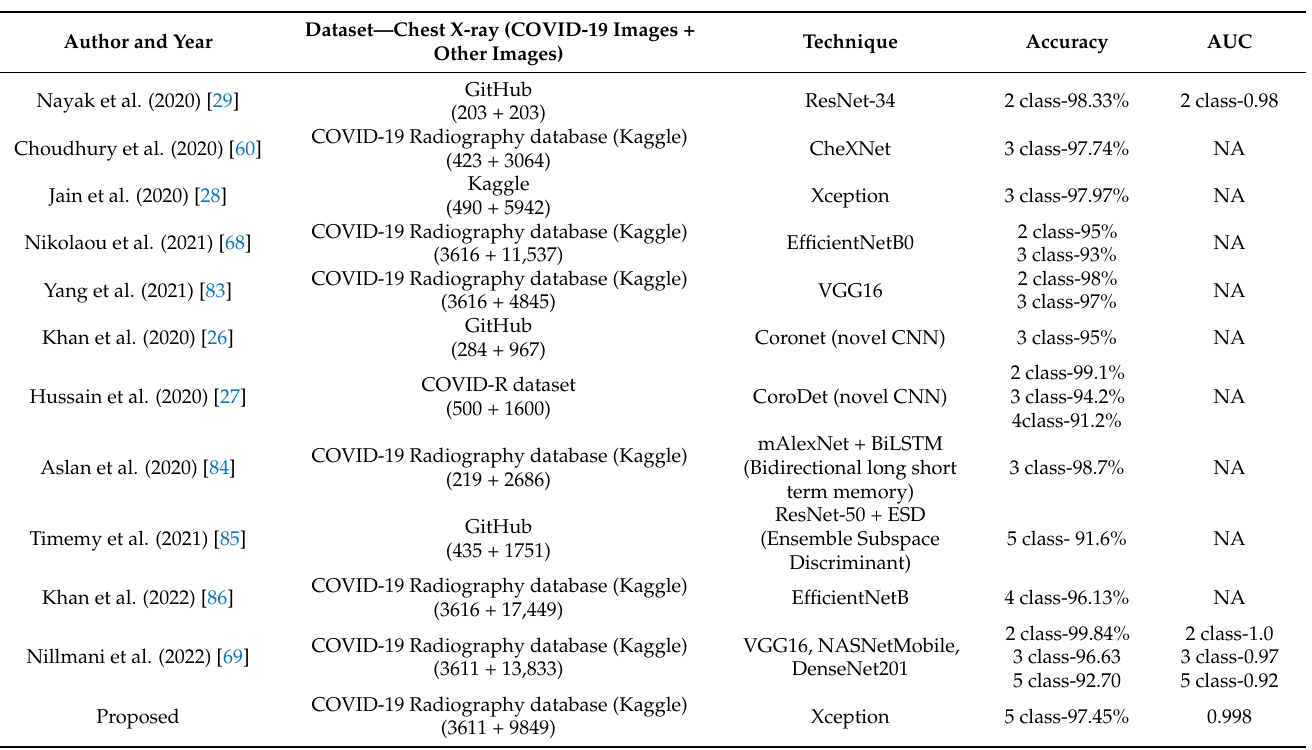
Table 5. Benchmarking table-showing comparison of proposed and existing classification (solo)